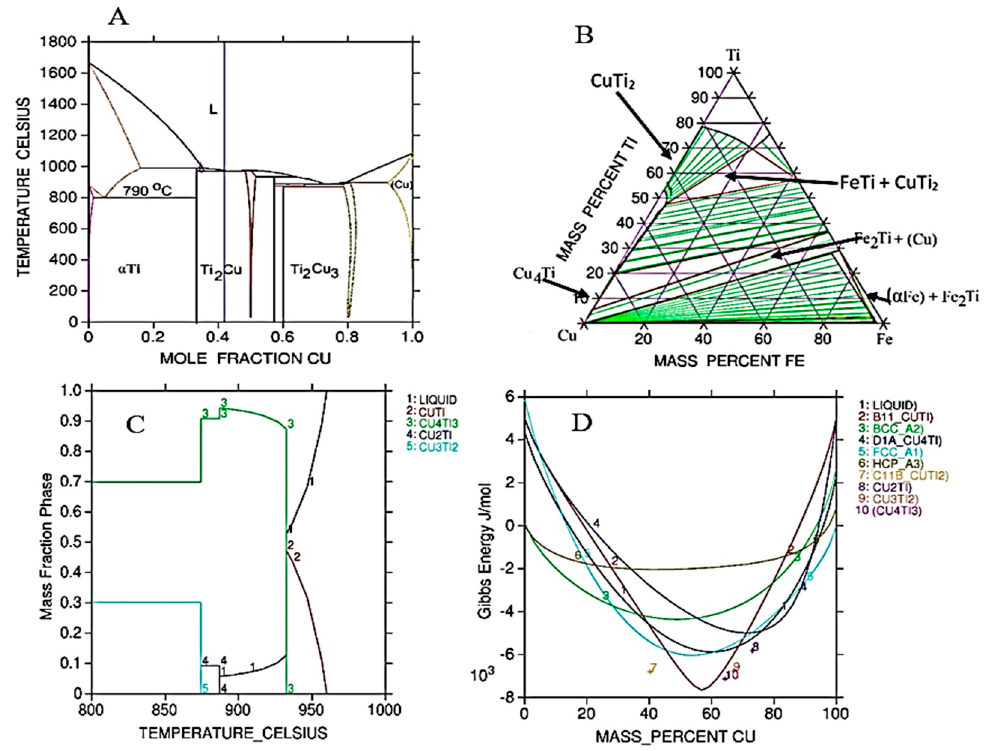
Figure 9. ( A ) BSE micrograph of a region on the Ti–6Al–4V and SDSS joint bonded at 850 ◦ C for 45 min with 25 µ m Cu foil. EDS line scanning analysis of elements ( B ) Ti, ( C ) Fe, and ( D ) Cu.